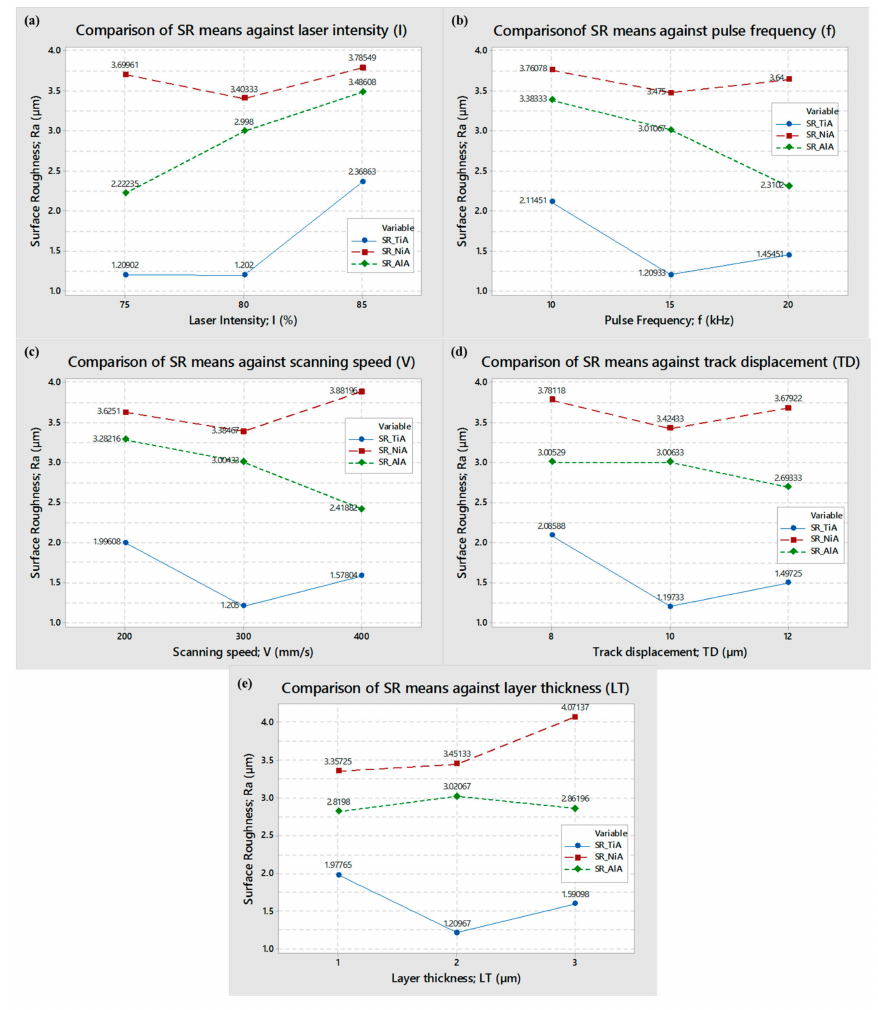
Figure 4. Mean e ff ects of laser parameters on surface roughness of TiA, NiA, and AlA. ( a ) e ff ect of current intensity, ( b ) e ff ect of pulse frequency, ( c ) e ff ect of scanning speed, ( d ) e ff ect of track displacement, ( e ) e ff ect of layer